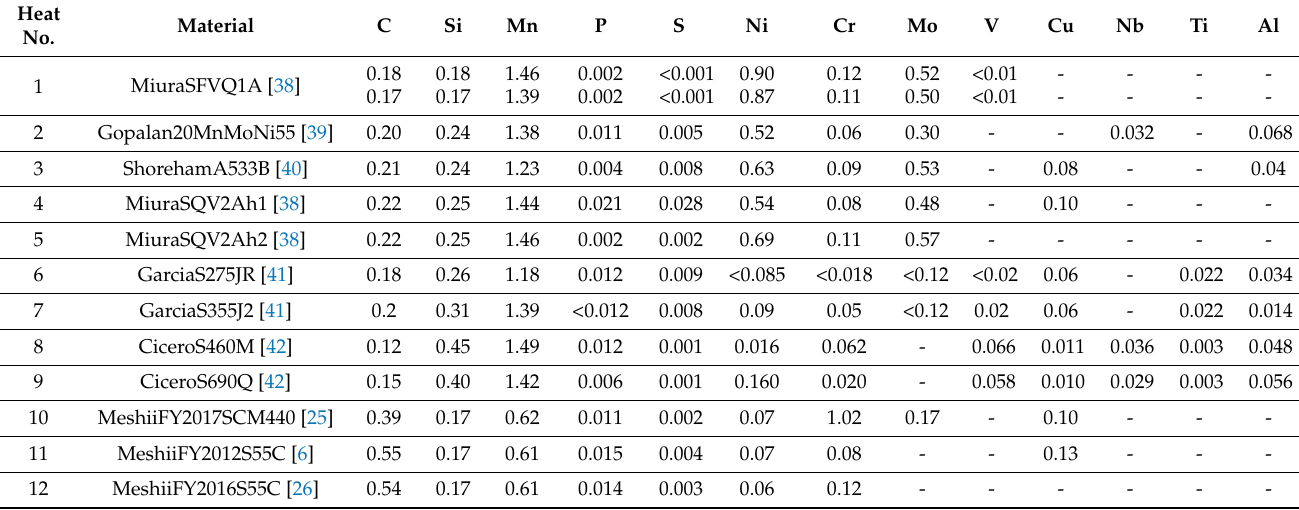
Table 1. Chemical compositions of the test specimens (wt %) of the considered materials.